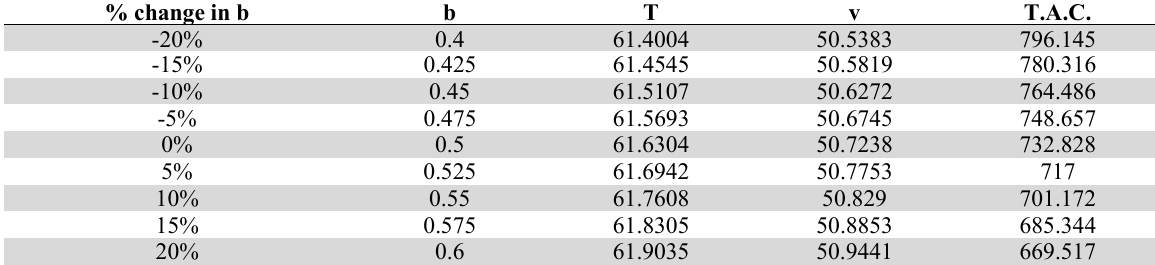
Effect on optimal solution for distinct values of demand parameter (b)